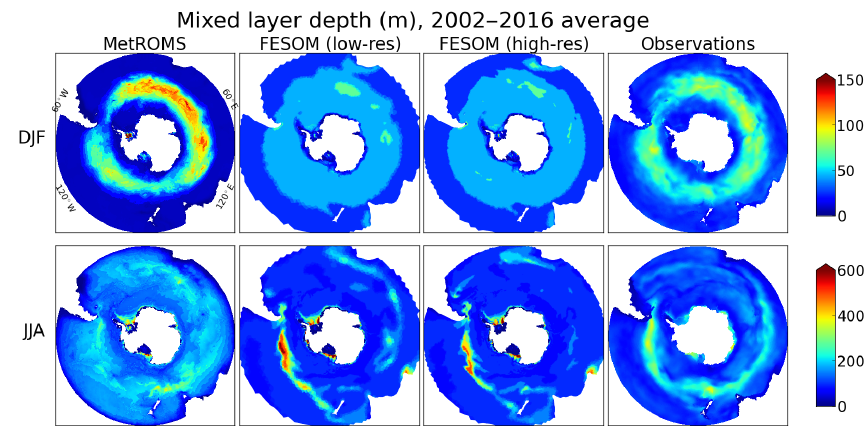
Figure 2. Mixed layer depth (m), calculated as the shallowest depth where potential density is at least 0.03kgm − 3 greater than at the surface or ice-shelf base. Results are shown for MetROMS, low-resolution FESOM, and high-resolution FESOM averaged over the years 2002–2016 for summer (DJF) and winter (JJA), as well as climatological observations by Pellichero et al. (2017) recalculated with the same definition of mixed layer depth. Note the different colour scale for summer and winter.